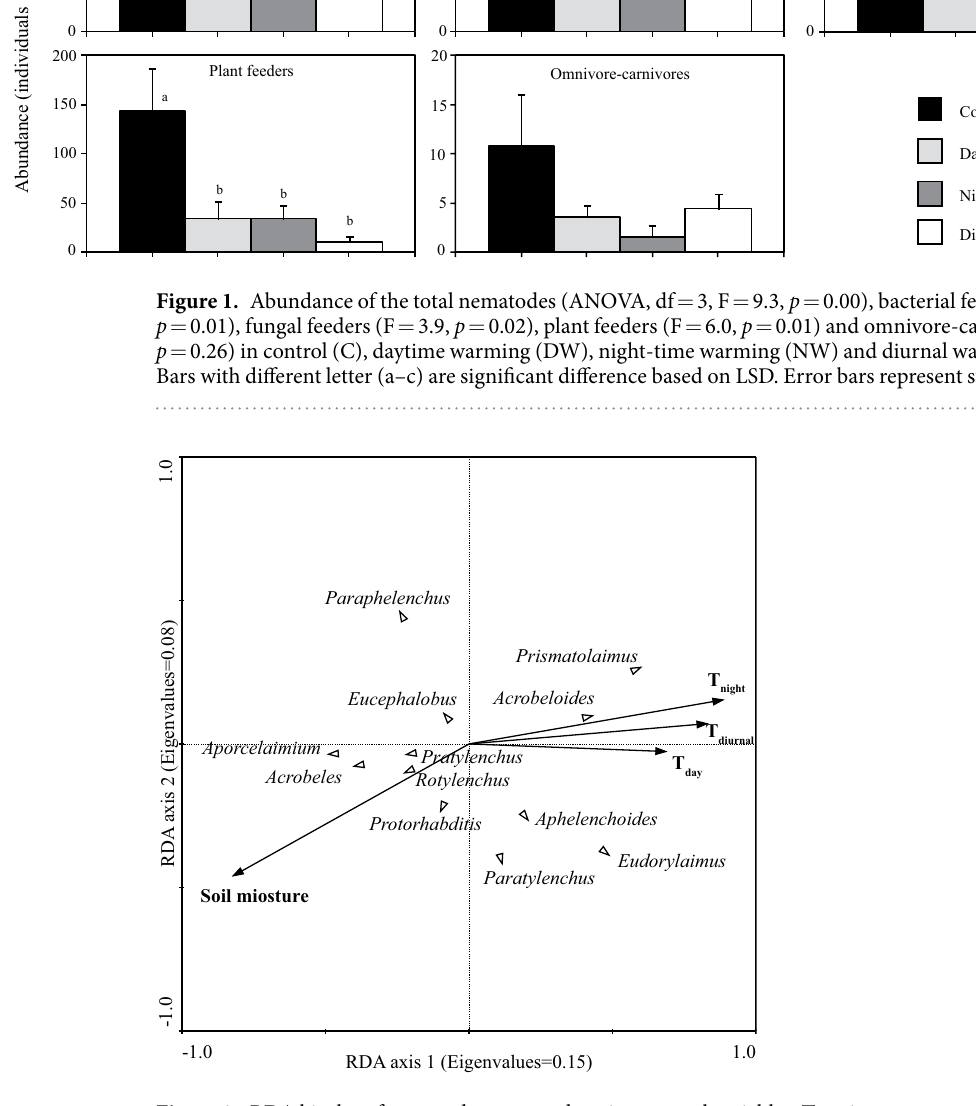
population, especially microbial-feeding nematodes. All the warming treatments significantly increased soil tem- perature, regardless of T day , T night or T diurnal (Table 1). However, soil warming did not affect (NW), even decreased (DW and 24 hW), soil nematode populations in the present study (Fig. 1). This indicated that temperature is not the determination factor for soil nematode community in the study area. It is well known that soil temperature and moisture content are among the main abiotic factors which directly or indirectly influence the activity, distribution and population dynamic of nematodes in the soil 20–22 . The increase of soil temperature coincided with a significant decrease of soil moisture (Table 1). Free-living nematodes were highly dependent on free water in soil for locomotion and biological activity, decreasing soil moisture content was expected to be a detrimental factor 18, 23, 24 . It was reported that, warming induced water shortage in soil reduced the density of nematodes in a multi-factor global change experiment in grassland 18 .